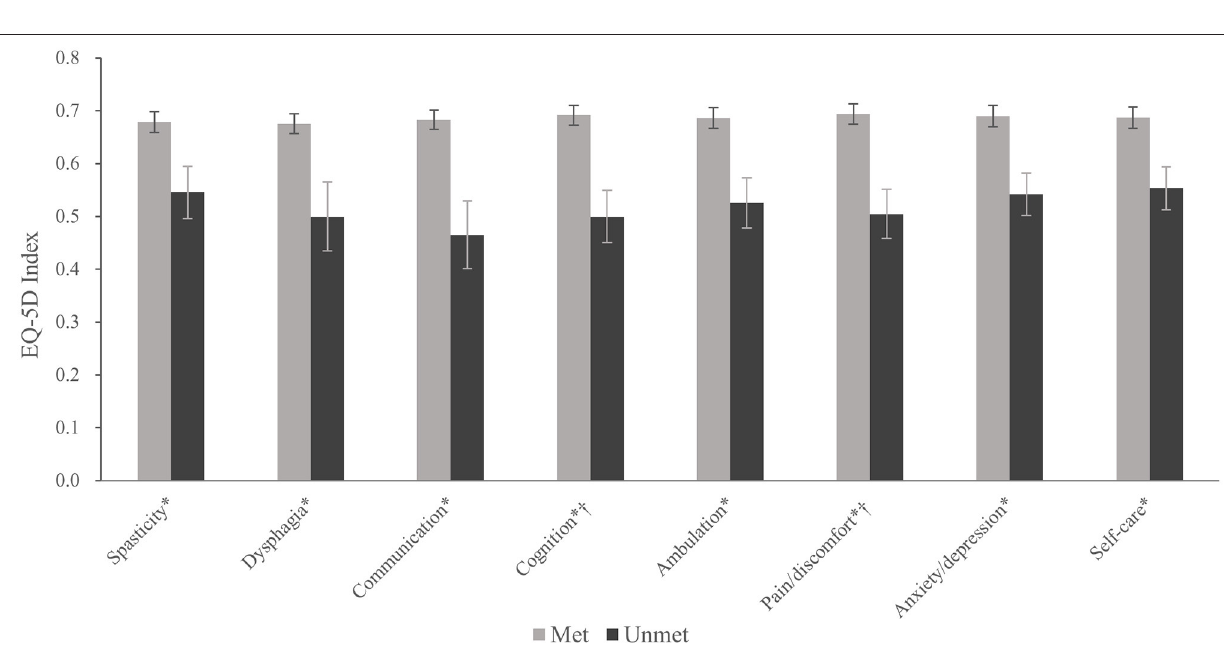
of met needs was high, while the rate of unmet needs was